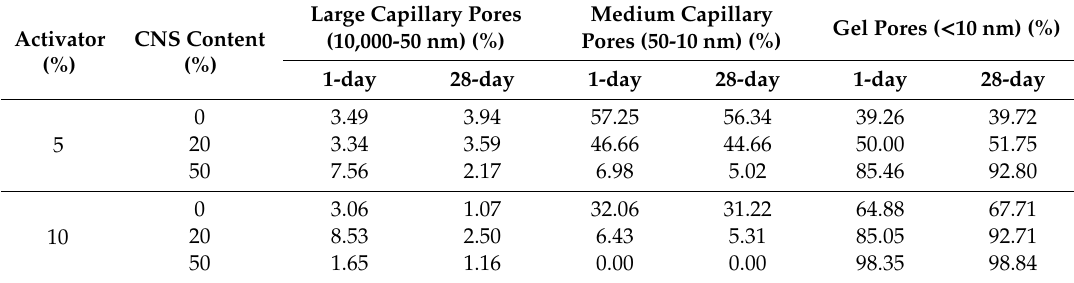
Figure 7. Total porosity of samples. Table 4. Pore size distribution of CNS